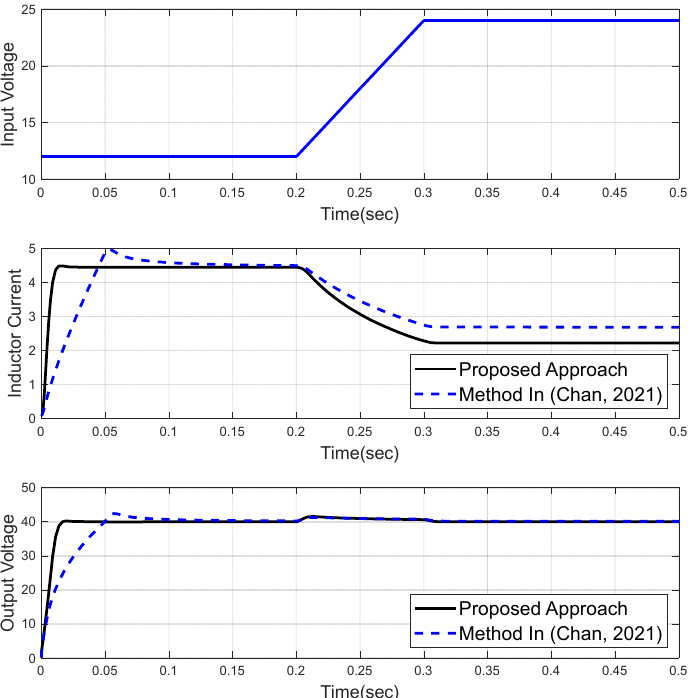
Figure 11. Comparison of the behaviour of the inductor current and output voltage with the results of the method in Ref. [1] in case of input voltage changes.